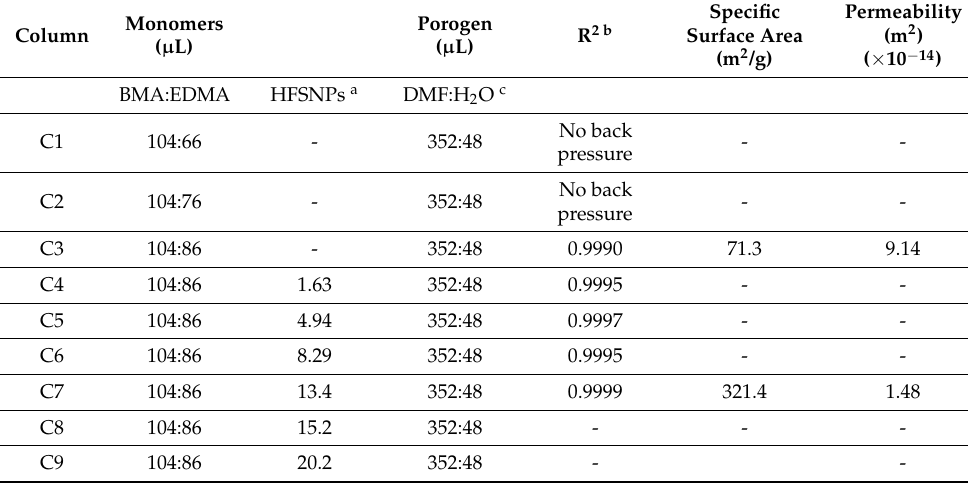
Table 1. Composition of the polymerization solutions used in the preparation of the monolithic columns with or without HFSNPs.